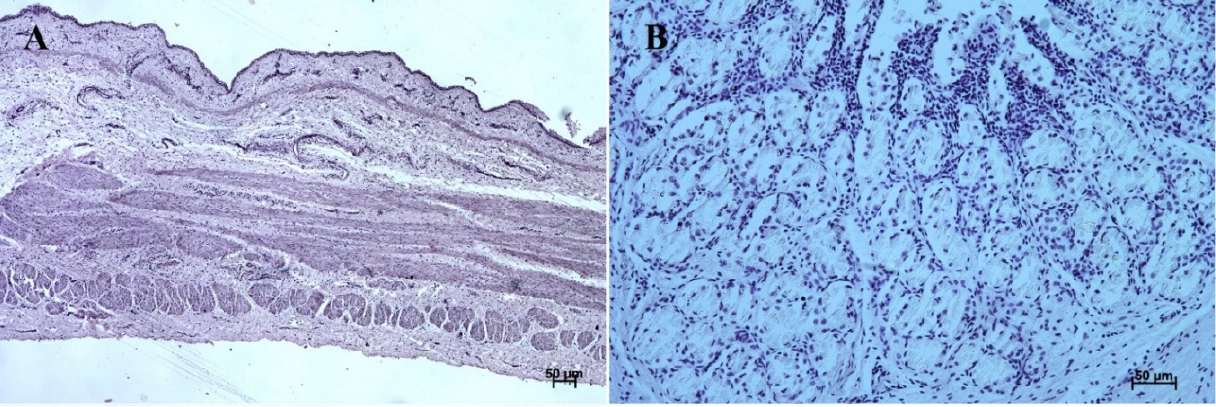
Figure 4. Histological structure of stomach mucosa in the cardiac part (hematoxylin-eosin staining). ( A )—the first age group (10×); ( B )—the second age group (20×); ( C )—the third group (5×); ( D )—the reference adult group (40×). Figure 5. Histological structure of stomach mucosa in the cardiac part (Masson-Goldner staining). ( A )—the first age group (20×); ( B )—the second age group (10×); ( C )—the third group (5×); ( D )—the reference adult group (10×).